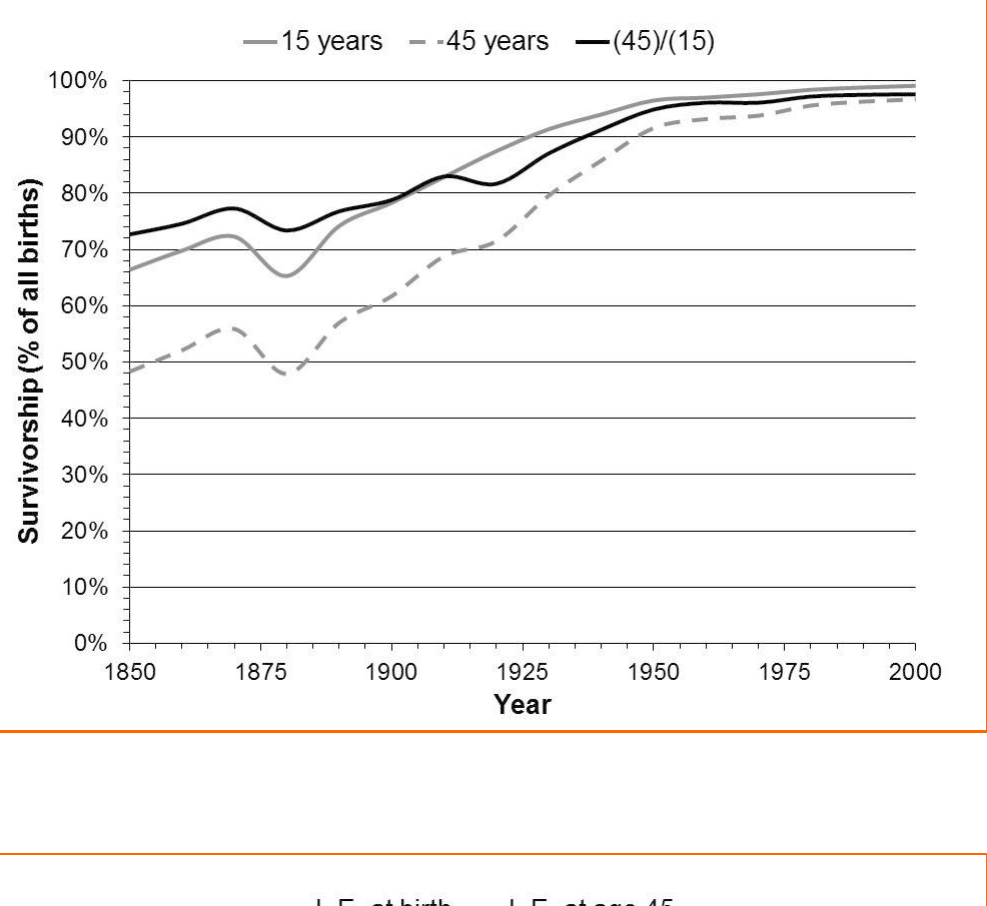
Figure 3: L.E. = Life expectancy, or average years of life remaining at a specific